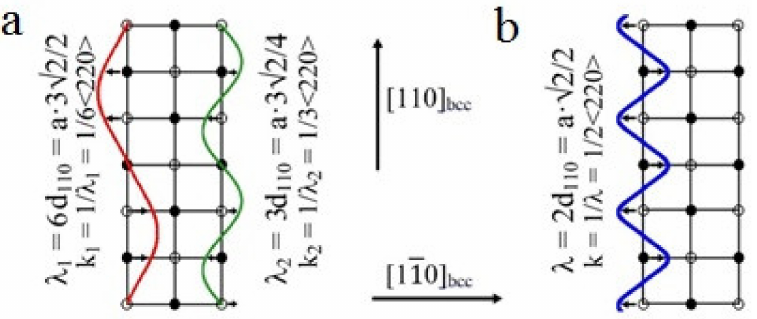
Figure 6. Schemes of shuffling offsets type of 1/6<220> k <1–10> e and 1/3<220> k <1–10> e ( a ) and 1/2<220> k <1–10> e ( b ) that provide transformations cubic lattice to D0 3 or L2 1